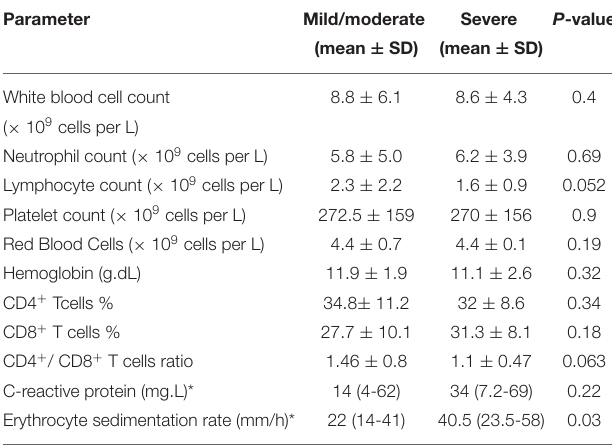
TABLE 2 | The patients’ laboratory findings and blood lymphocyte subsets of children with COVID-19.